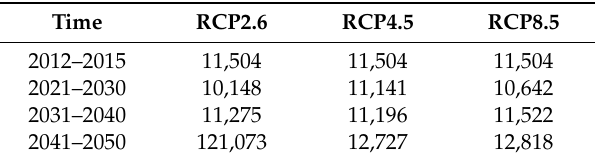
Table 5. Decadal changes of the maize yield in the Ganzhou area under the three RCP scenarios (unit: kg / ha).